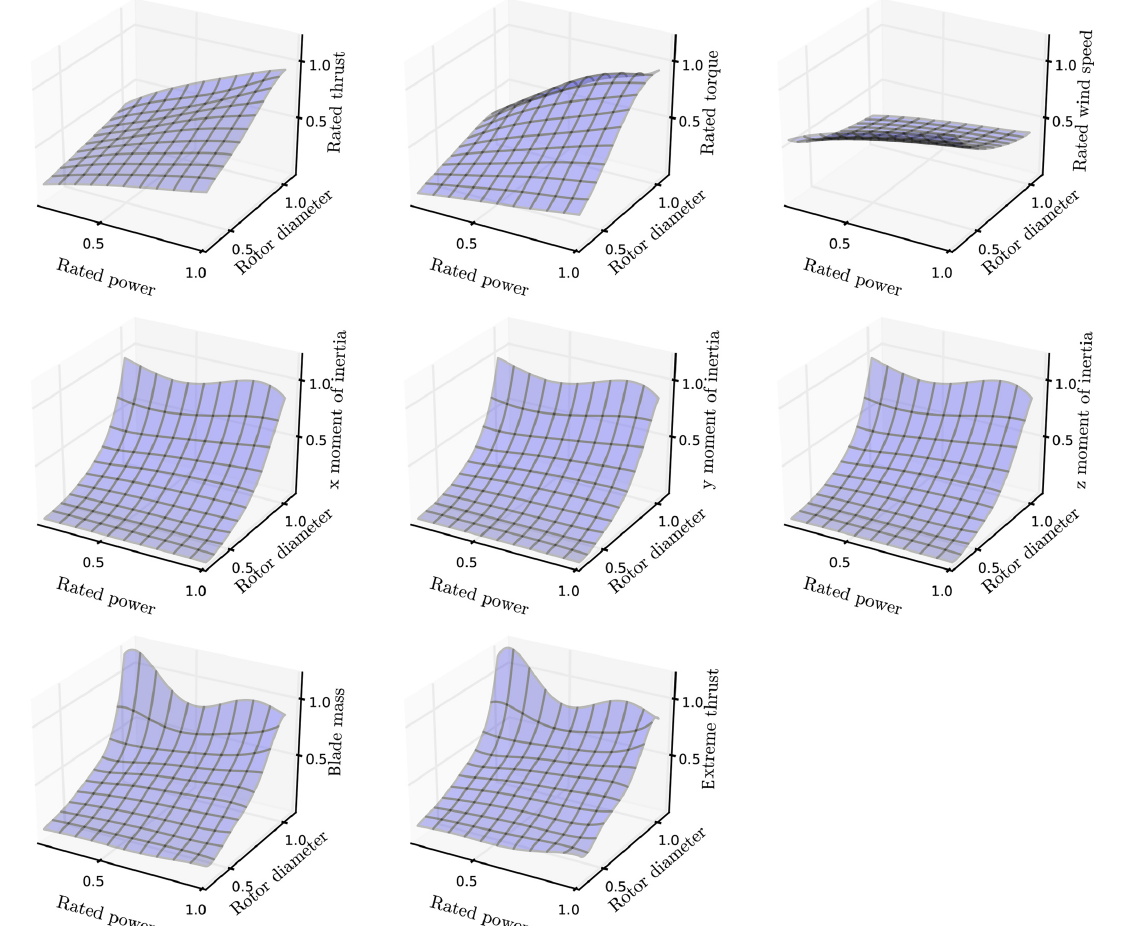
Figure 2. The spline fits to optimized RotorSE data. These fits were used to obtain the desired outputs of rotor mass, rated and extreme thrust, rated torque, rated wind speed, and moments of inertia as functions of the rotor diameter and rated